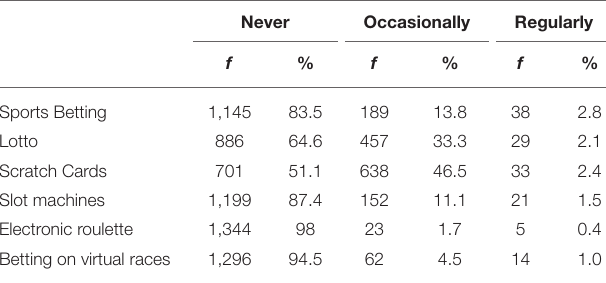
TABLE 2 | Frequency of Gambling ( N = 1,372). TABLE 3 | Frequency of regular gambling according to CAGI categories ( N =